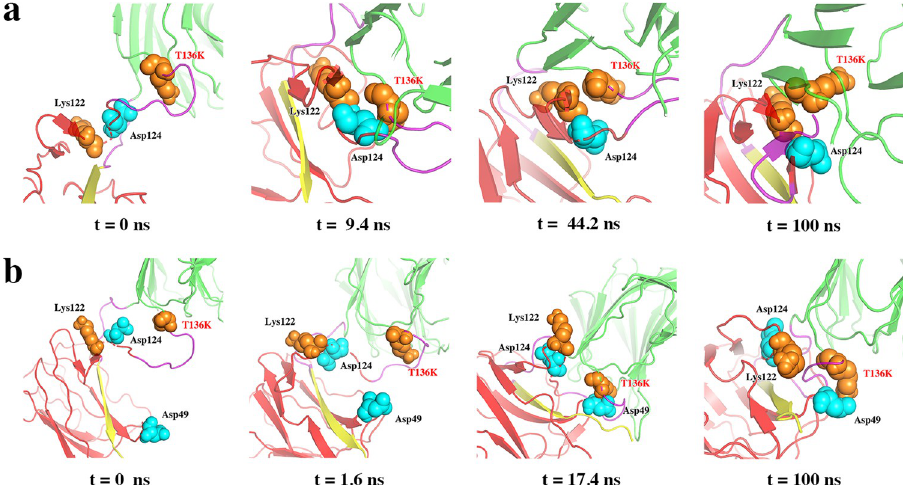
Fig 2. Structure in simulated trajectory of T136K. (a) and (b) are two simulation results. (a) Lys136 and Asp124 first approached each other and then separated again, which might be due to the electrostatic repulsion of Lys122. (b) It is not Asp124 but Asp49 and Lys136 form a strong electrostatic interaction and are close to each